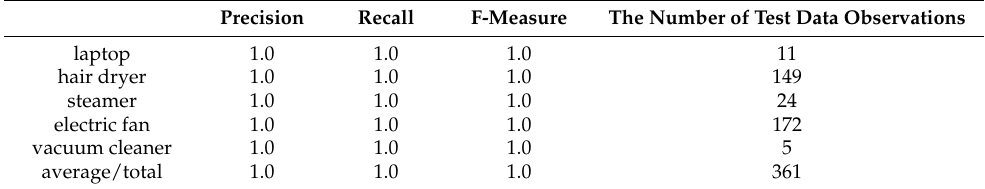
Table 2. Load recognition results obtained by the specified and trained feed-forward ANN in test.